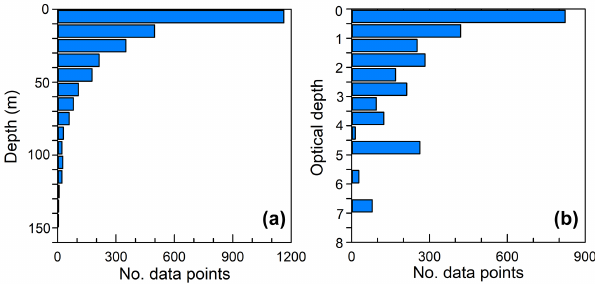
Figure 3. Frequency of CaCO 3 production data by (a) sampling depth and (b) optical depth. Depths relate to depth of sample col- lection, not incubation